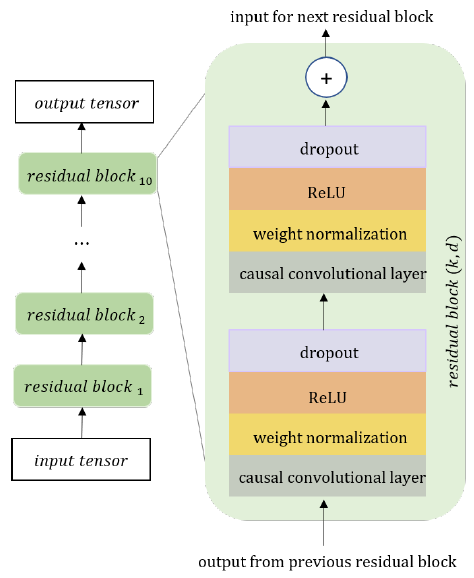
Figure 2. The temporal neural network architecture. It includes a total of R b = 10 residual blocks, receptive field r f = 8, dilation base d = 2 and the kernel size k =